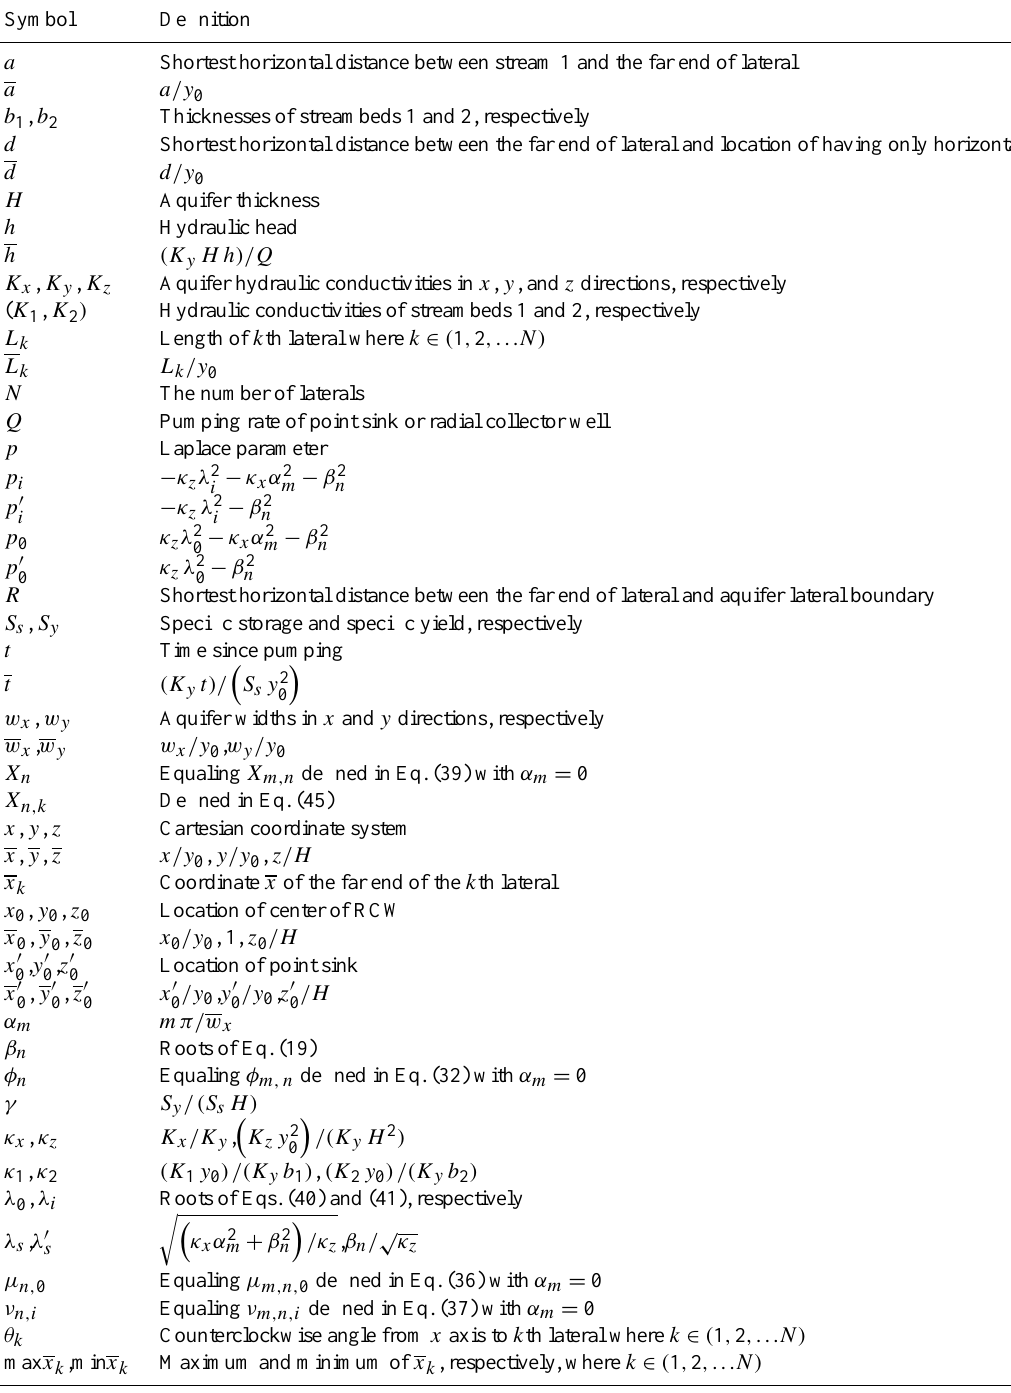
Table 1. Symbols used in the text and their